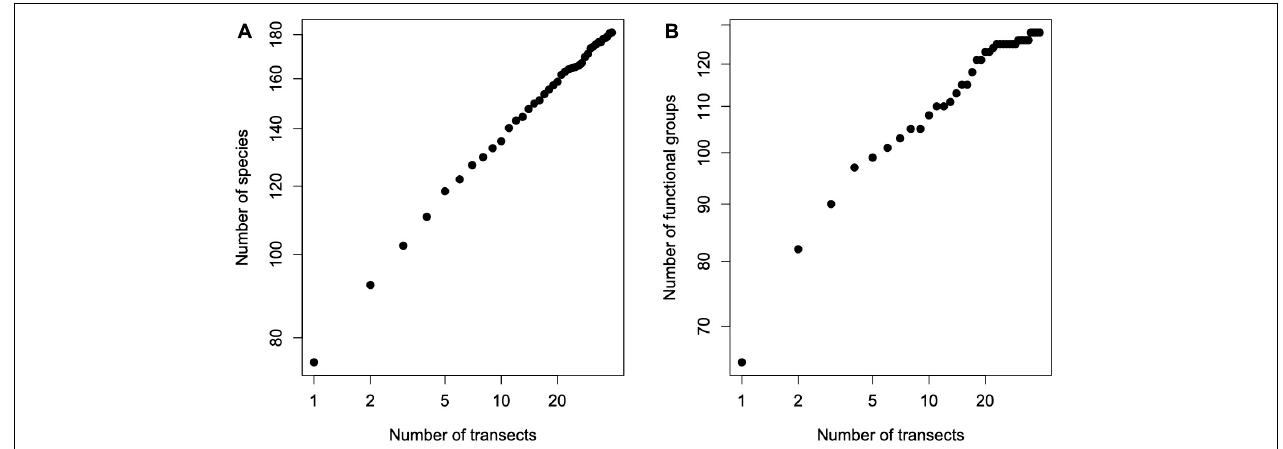
FIGURE 3 | The species-area relationship (SAR), plot (A) , and the functional units area relationship (FUAR), plot (B) . Recall that all transects have the same dimensions, thus we equate the number of transects with area size. Both plots are on double logarithmic scales. Notice that the SAR exhibits the typical linear relationship when plotted on double logarithmic scales (i.e., it is approximately a power law relationship) while the FUAR shows some signs of reaching a